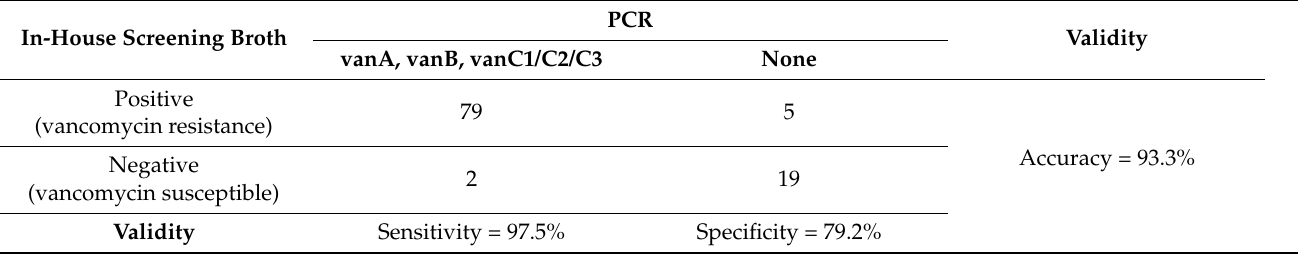
Table 3. Validity of in-house VREfm screening broth to determine vancomycin resistance compared with PCR detecting van